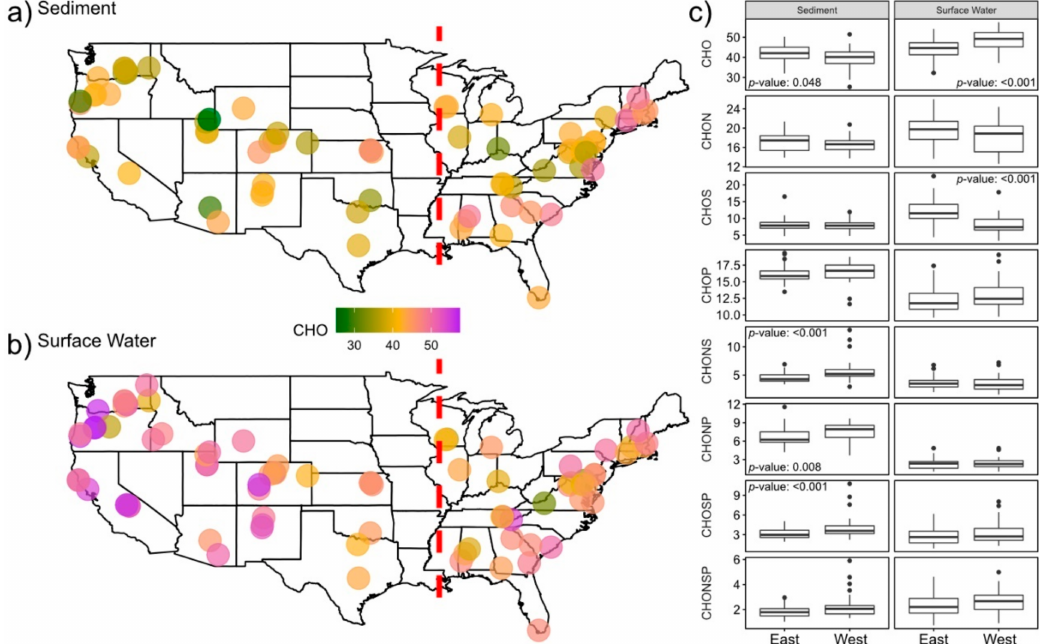
Figure 6. Maps of the United States revealing the spatial variability of the relative abundance of metabolites containing only CHO with sediment ( a ) and surface water ( b ); East vs. West spatial patterns for di ff erent elemental groups’ relative abundances are displayed in panel ( c ). Statistically significant di ff erences identified via a two-sided Mann-Whitney U test are indicated by p -values listed in each comparison. The red dashed line represents the longitude of the Mississippi River at St. Louis, MO, USA—the dividing line between East and West